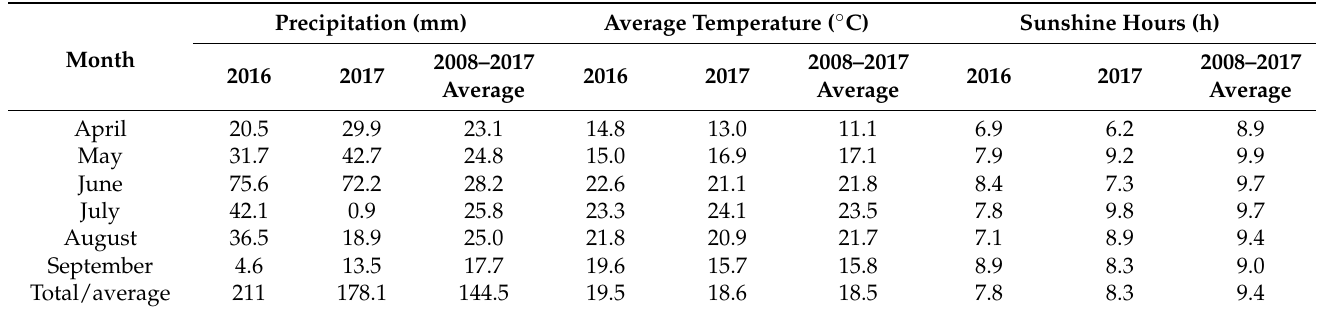
Table 1. Precipitation, air temperature, and sunshine hours during maize growing seasons of 2016 and